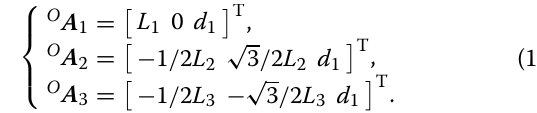
The positions of the three spherical joints in the mov- ing platform coordinate system { B } are expressed in Eq.